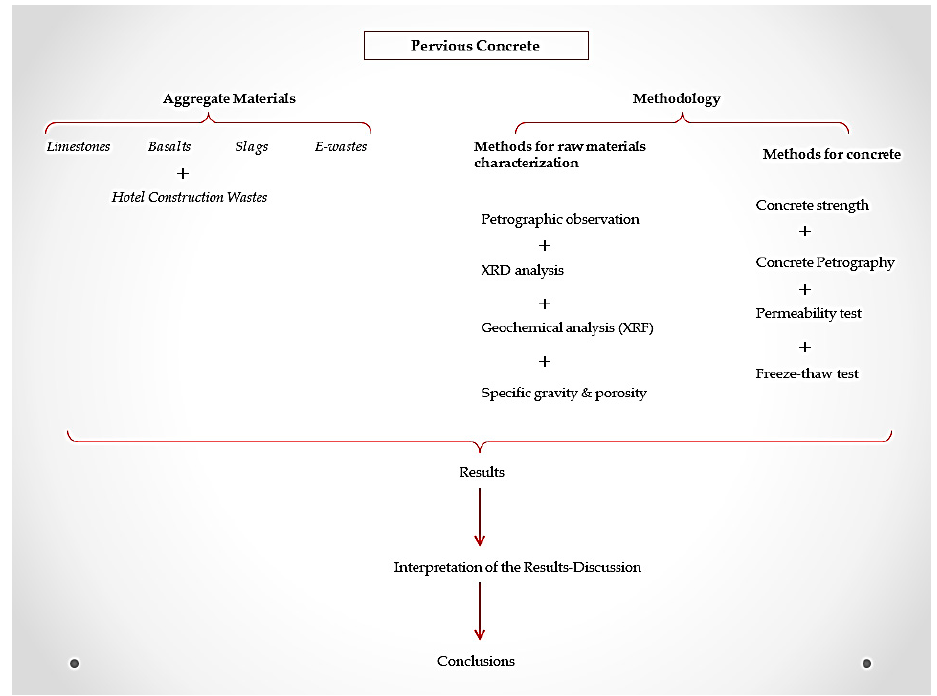
Figure 2. Flow chart that describes the aggregate materials and the methods followed in this